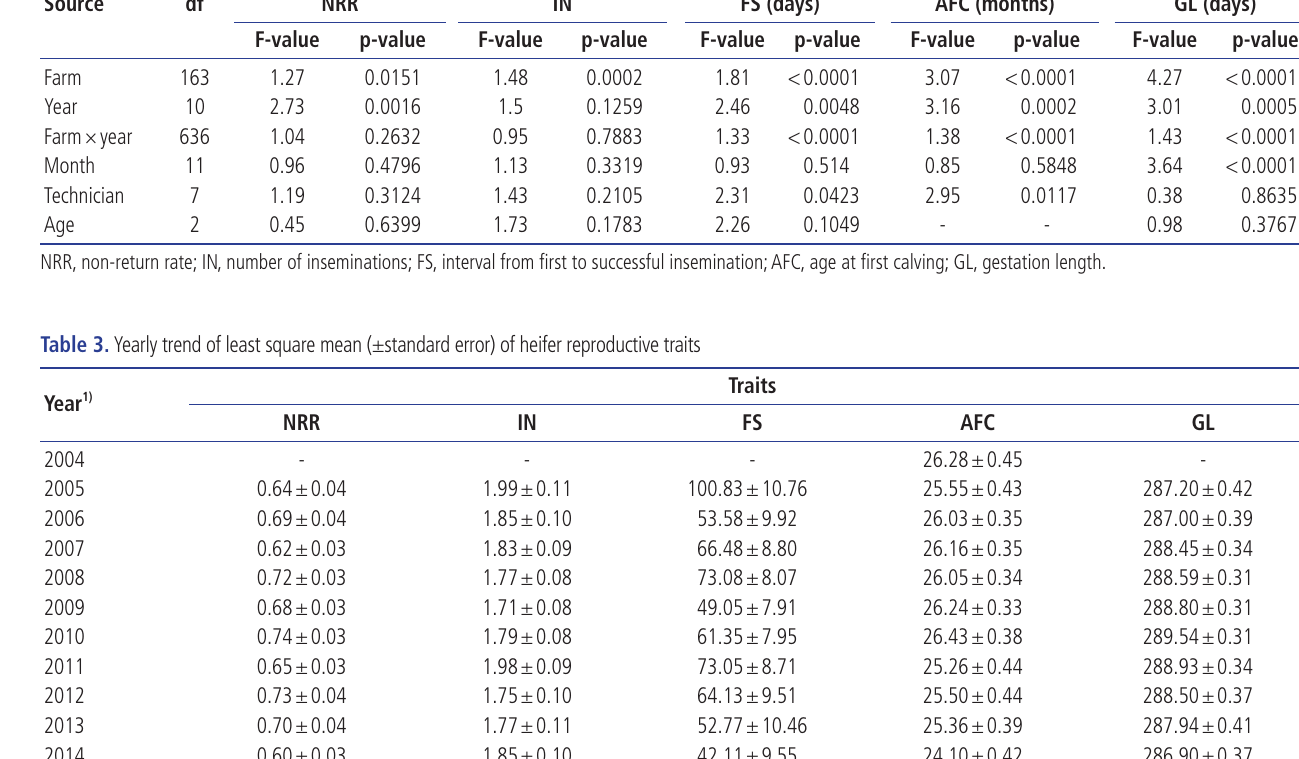
Table 2. Significance of factors affecting heifer reproductive traits Source df